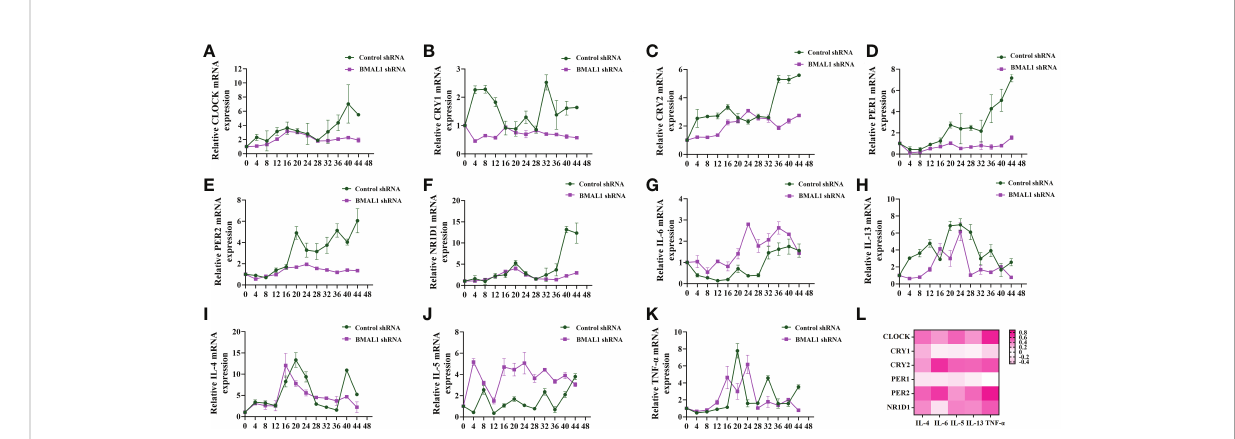
FIGURE 5 BMAL1 knockdown results in lower correlation between circadian clock genes with rhythm clock genes. (A – F) RT-qPCR analysis of the mRNA levels of circadian clock genes (CLOCK, CRY1, CRY2, PER1, PER2, and NR1D1) in control shRNA and BMAL1 shRNA cells in response to serum shock synchronisation. (G – K) RT-qPCR analysis of the mRNA levels of in fl ammatory cytokines (IL-6, IL-13, IL-4, IL-5, and TNF-a) in control shRNA and BMAL1 shRNA cells in response to serum shock synchronisation. (L) Heat map of the matrix coef fi cient correlation of each circadian clock gene and in fl ammatory cytokines in BMAL1 shRNA cells. Stronger Pearson ’ s correlation coef fi cients (r) are represented in red. ZT, zeitgeber time. All data shown are representative data of one out of at least 3 independent experiments. Pearson ’ s correlation coef fi